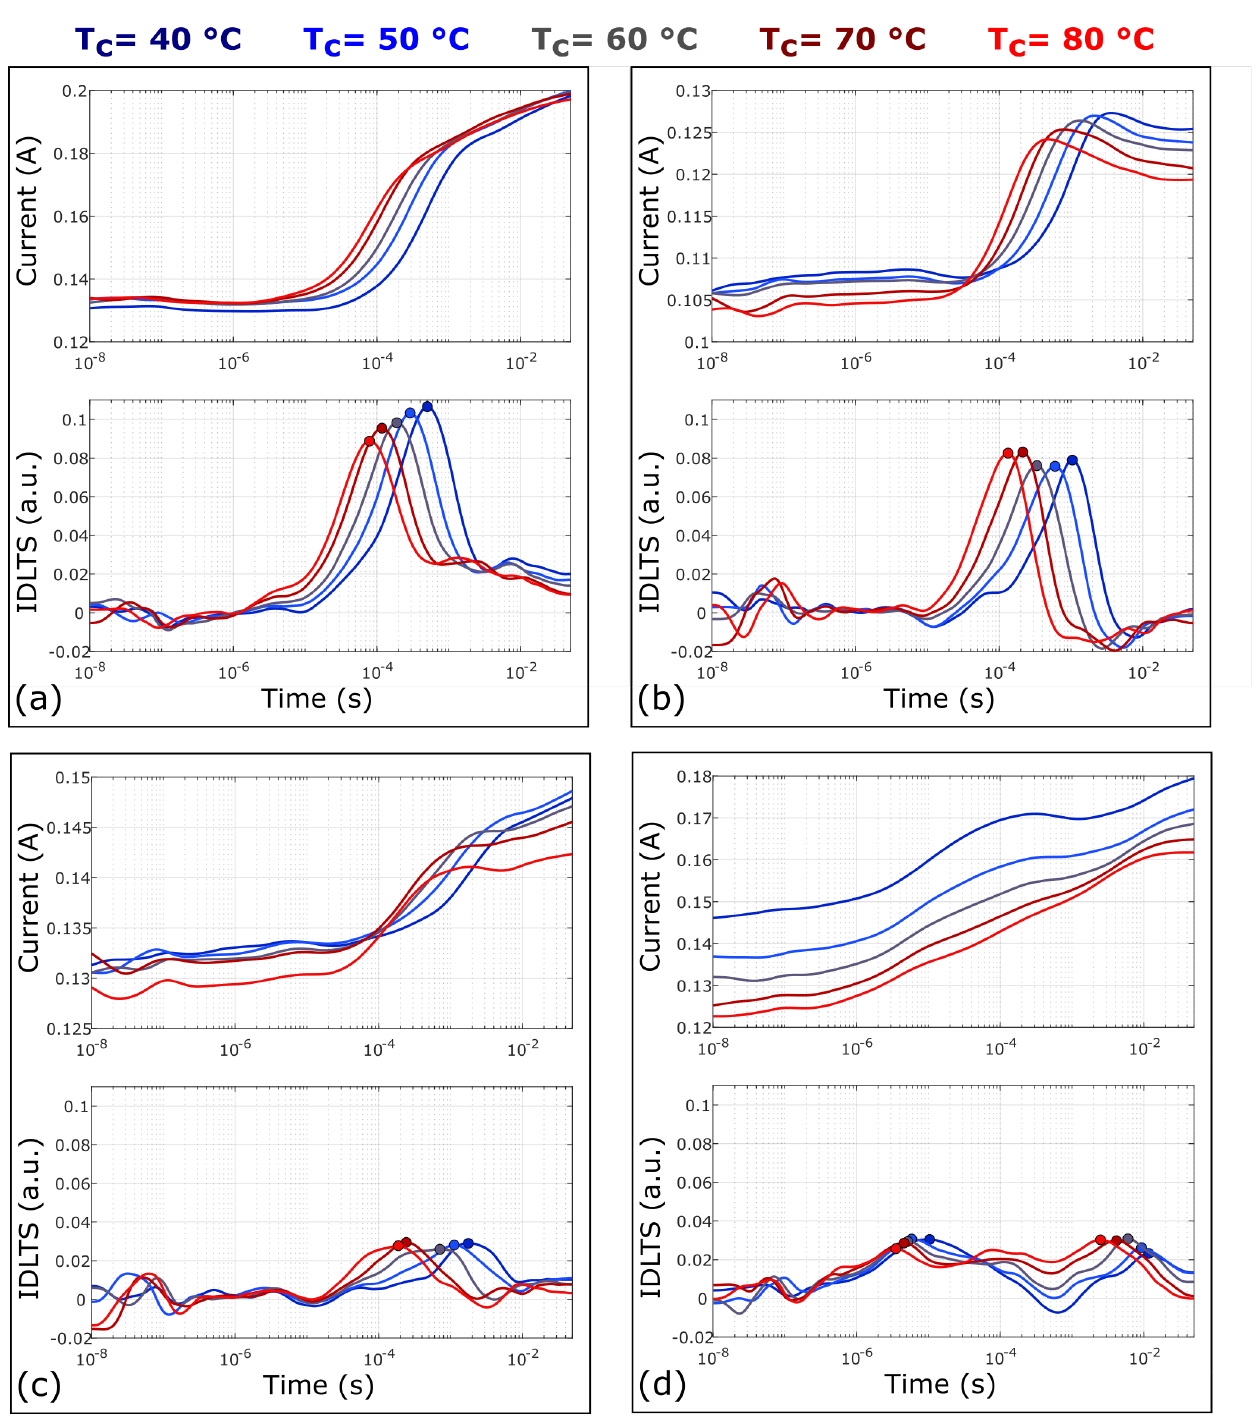
Figure 11. Comparison of the current transients (top plots) and the corresponding time-derivative traces (bottom plots) among the four studied technologies for a baseplate temperature range T c = 40–80 ◦ C . The time-derivative traces are referred to as I-DLTS as from Reference [31]. Devices A – D are reported in ( a – d ), respectively. The transients correspond to the DL → MI transition, with values as from Table